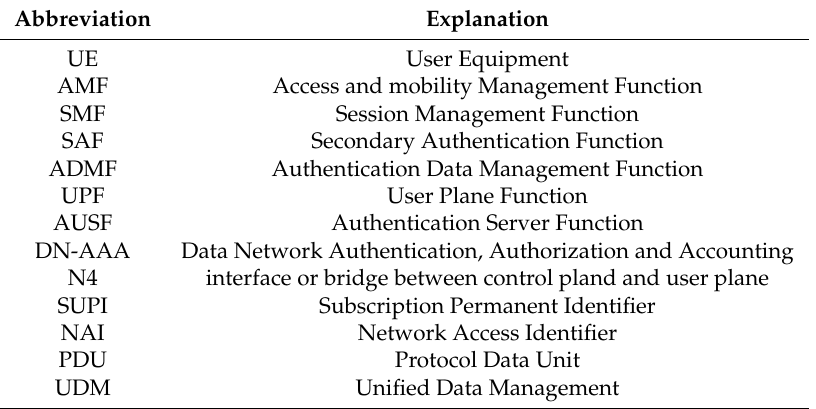
Figure 1. The proposed network architecture. Table 2. Entities of Secondary Authentication in 5G’s Security